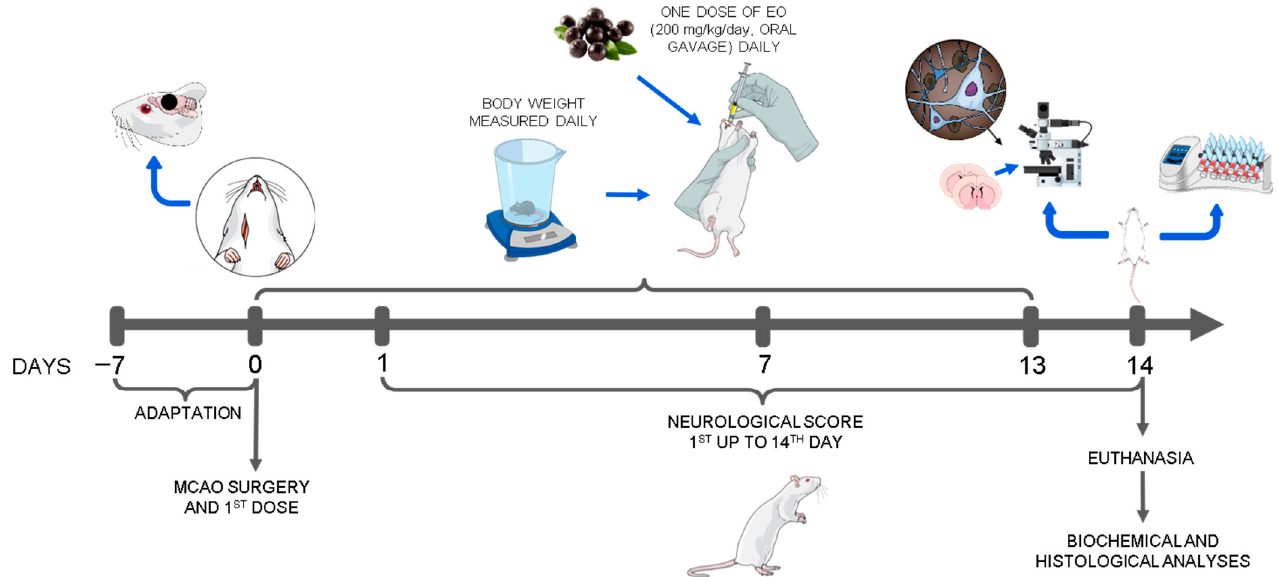
Figure 1. Experimental design using the animals submitted to middle cerebral artery occlusion (MCAO) and treated with clarified extract of Euterpe oleracea (EO).